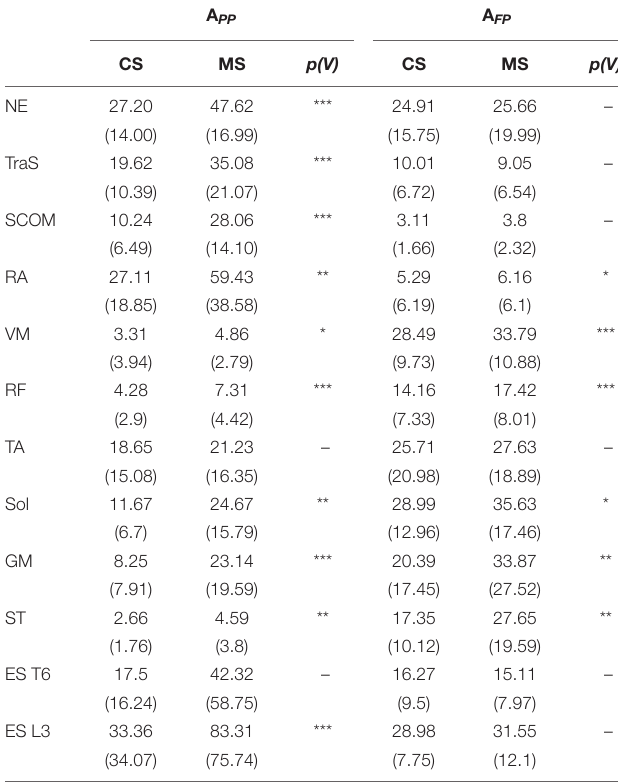
TABLE 4 | Mean (SD) muscle activity levels in the postural phase (A PP ) and in the focal phase (A FP ) in % MVC for the 2 speed conditions: comfortable speed (CS) and maximal speed (MS), calculated for the 5 backrest inclination